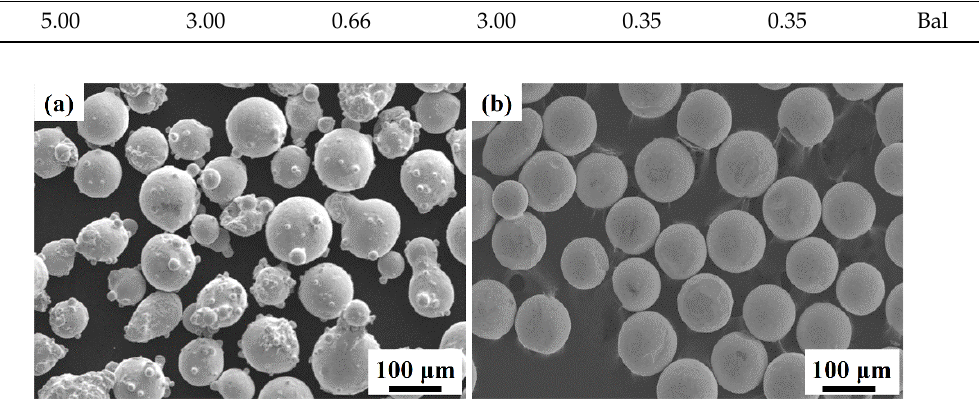
Figure 1. Morphologies of powder particles ( a ) IN718 and ( b ) WC.